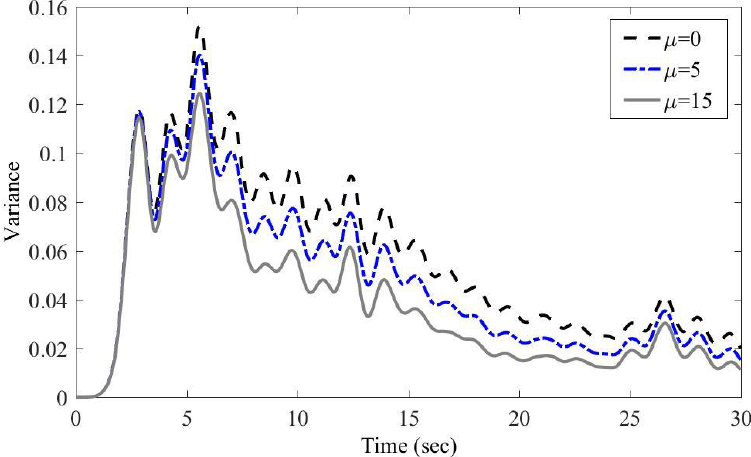
Figure 11. Mean square displacement response due to ground motion excitation ( γ = 1.0).